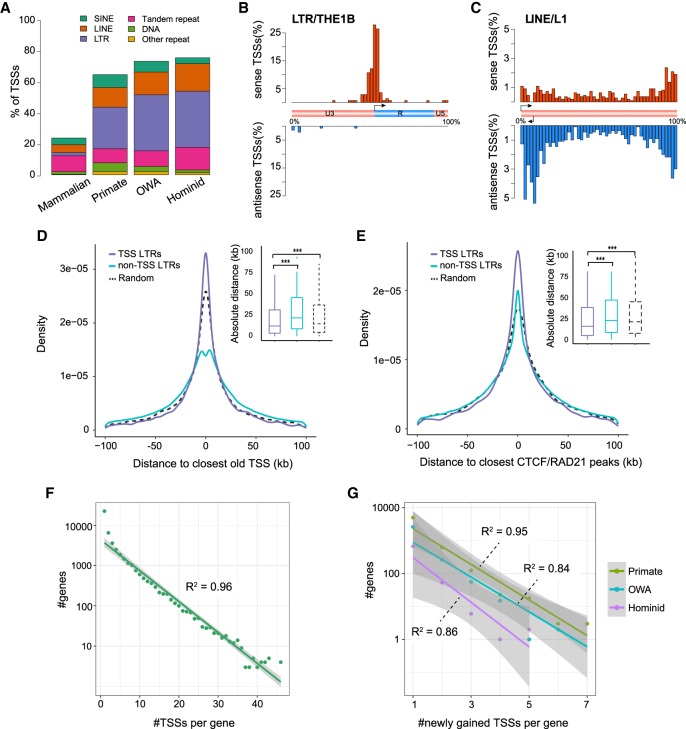
Intrinsic and extrinsic factors contributing to the origin of new TSSs. (A) Composition of major repeat families in four TSS groups. We considered the nearest repeat element within TSS ± 100 bp. (B) Distribution of young TSSs plotted against the consensus LTR/THE1B element. Schematic of THE1B indicates the original TSS, U3, R, and U5 regions for the element. (C) Distribution of young TSSs plotted against the consensus LINE/L1 element. Schematic of the L1 structure indicates the original sense and antisense TSSs at the 5′ end. (D) Comparison of distances of TSS-associated and non-TSS-associated LTRs to the closest old TSSs. Distances of random intervals to the closest old TSSs are also provided for comparison. Inset shows a box plot of the same distribution. (E) Comparison of distances of TSS-associated and non-TSS-associated LTRs to the closest CTCF or RAD21 ChIA-PET peaks (from GM12878; only mammalian-conserved peaks were used). Distances of random intervals are calculated in a similar manner to panel D. Inset shows a box plot of the same distribution. (F) Exponential approximation for the number of genes with a certain number of TSSs and number of TSSs per gene, based on data of all TSSs. R2 is the coefficient of determination for the linear regression. Gray shade indicates the 95% confidence interval. (G) Exponential approximation for number of genes and number of newly gained TSSs per gene, based on data of newly emerged TSSs in three periods. Statistical significances in D and E were calculated by one-tailed Wilcoxon rank-sum tests; (***) P < 0.001.